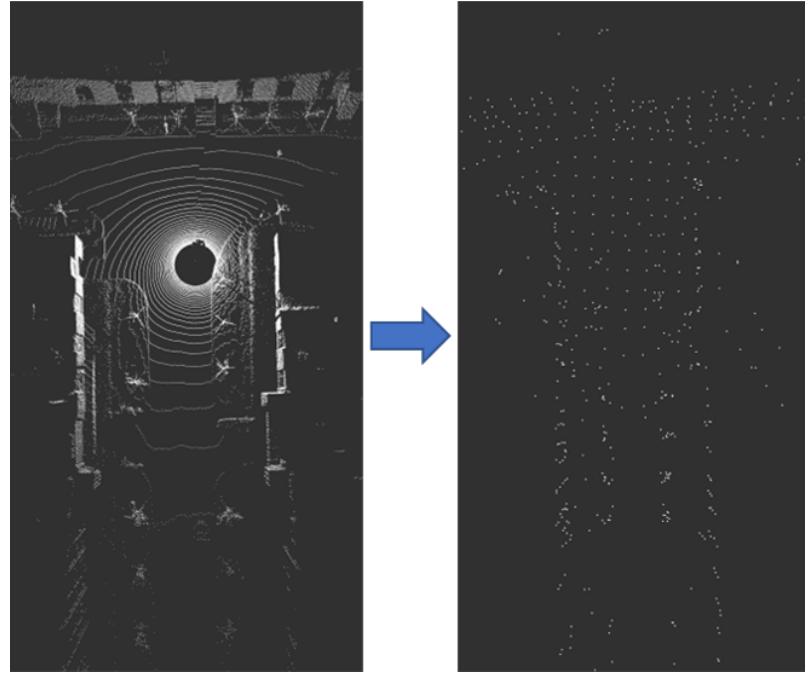
Figure 4. LiDAR point cloud data